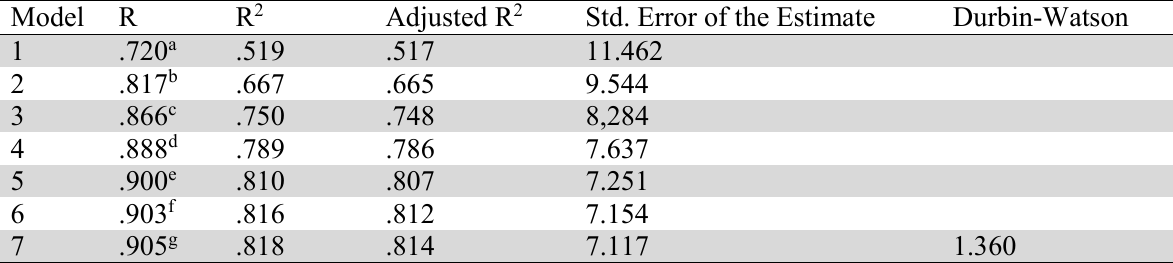
Model Summary b Model Std. Error of the